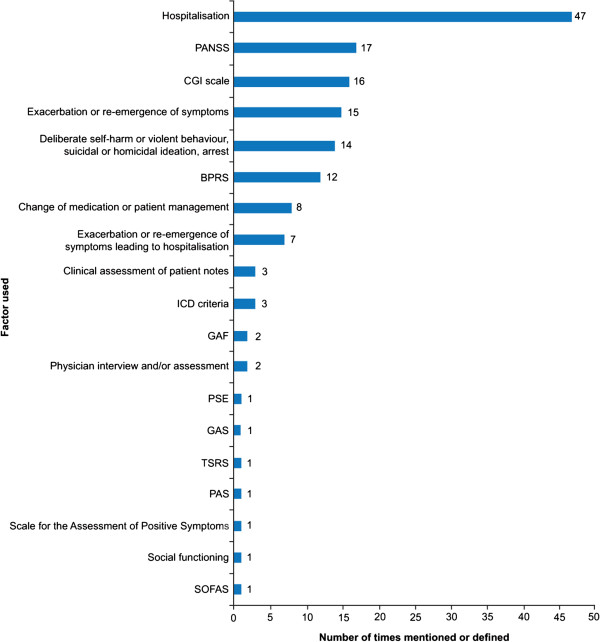
Reported components of the definition for relapse. Hospitalization [11,15-59]; Positive and Negative Syndrome Scale (PANSS) [7,15,17,18,60-72]; Clinical Global Impression (CGI) scale [17,18,26,30,52,57,60-62,65],[66,68,71,73,74]; exacerbation/re-emergence of symptoms [7,27,29,34,38,43,63,67],[75-81]; deliberate self-harm or violent behaviour, suicidal or homicidal ideation, arrest [18,23,27,43,49,50,57,65],[66,71,74,82-84]; Brief Psychiatric Rating Scale (BPRS) [28,43,71,76,84-91]; change of medication or patient management [18,27,38,41,56,66,75,92]; exacerbation/re-emergence of symptoms leading to hospitalization [20,66,92-96]; clinical assessment of patient notes [38,57,88]; International Classification of Diseases (ICD) criteria [70,89,97]; Global Assessment of Functioning (GAF) [64,72]; physician interview and/or assessment [86,98]; Present State Examination (PSE) [84]; Global Assessment Scale (GAS) [84]; Target Symptoms Ratings Scale (TSRS) [76]; Psychiatric Assessment Scale (PAS) [99]; scale for the assessment of positive symptoms [86]; social functioning [75]; Social and Occupational Functioning Assessment Scale (SOFAS) [60].